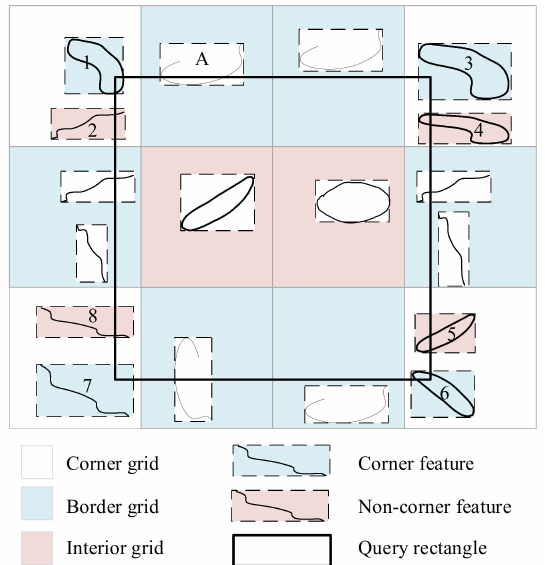
Figure 5. Grids covered by a rectangle. The dashed rectangles indicate the features’